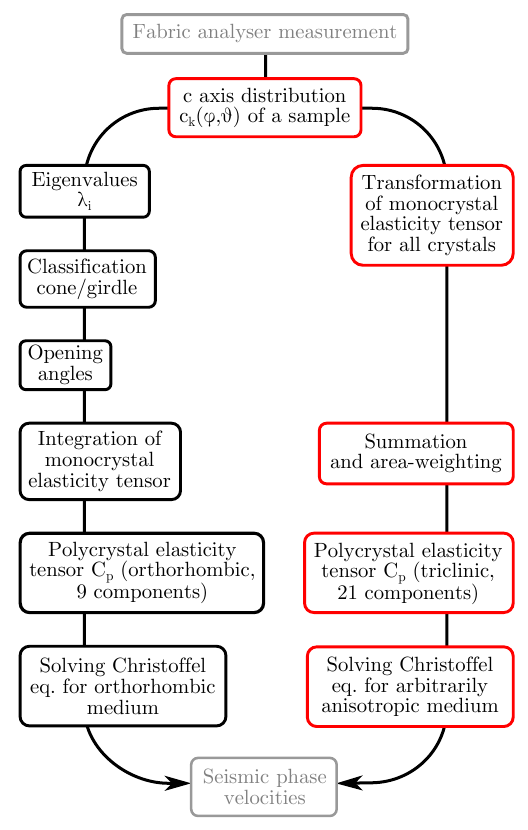
Figure 2. Flow chart to illustrate the steps for both frameworks. The workflow for the ev framework is framed in black boxes, starting with the eigenvalues. The workflow for the cx framework is framed in red and uses the c axis distribution as